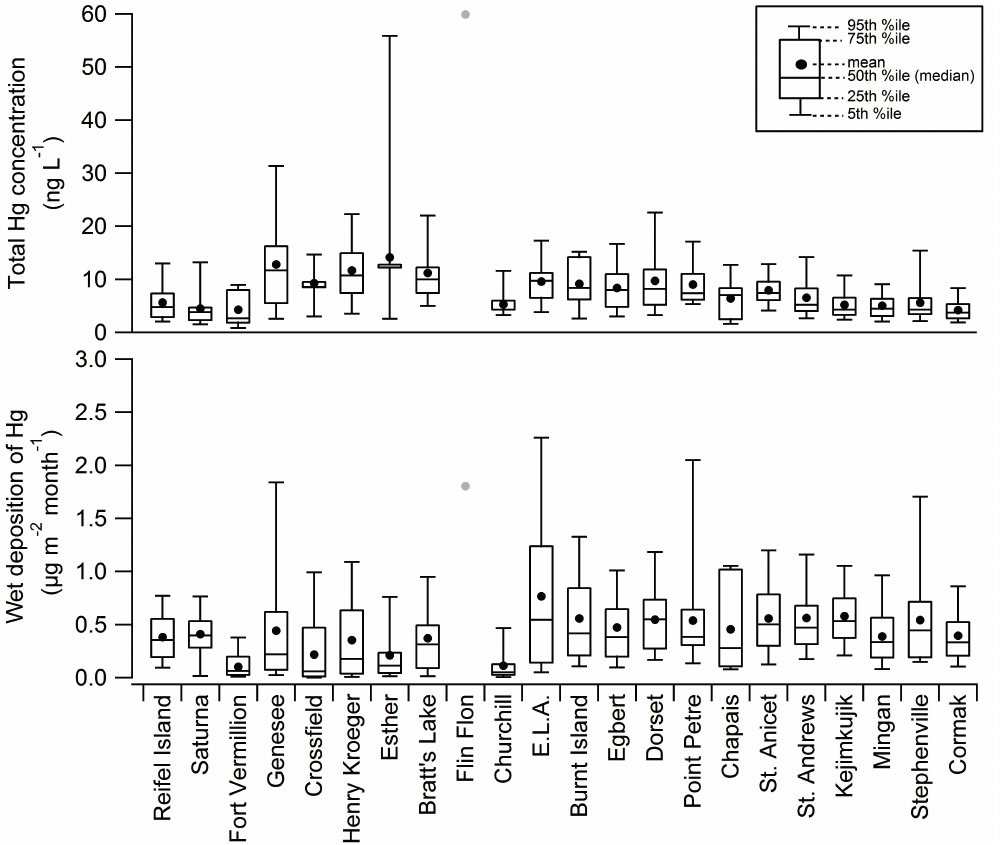
Figure 4. Comparison of total Hg concentrations in precipitation (top) and monthly wet deposition (bottom), with only the mean shown for Flin Flon. Time periods covered by measurements are listed in Table 3. The distributions are based on monthly volume-weighted means and monthly deposition amounts, which were first calculated from weekly samples (see